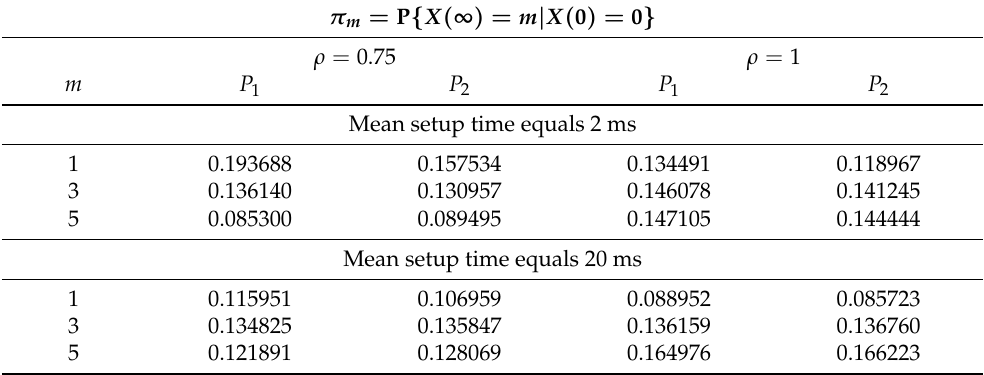
Table 1. Stationary distributions π m for utilization factors ρ = 0.75, ρ = 1, batch size distributions P 1 , P 2 and mean setup times equal 2 and 20